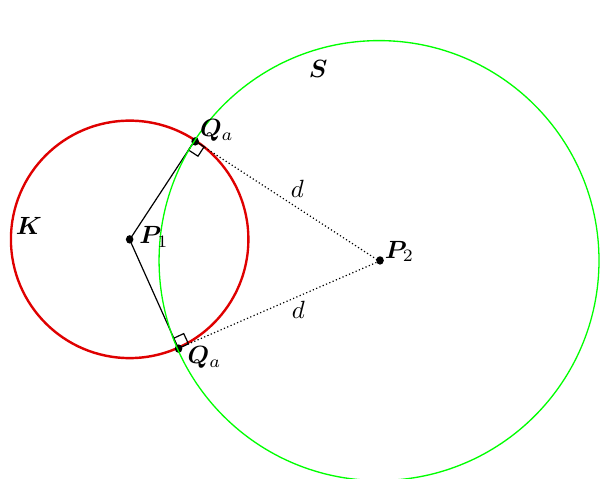
Figure 1: The point pair Q a are two points which are d away from P 2 and 90 ◦ between P 1 and P